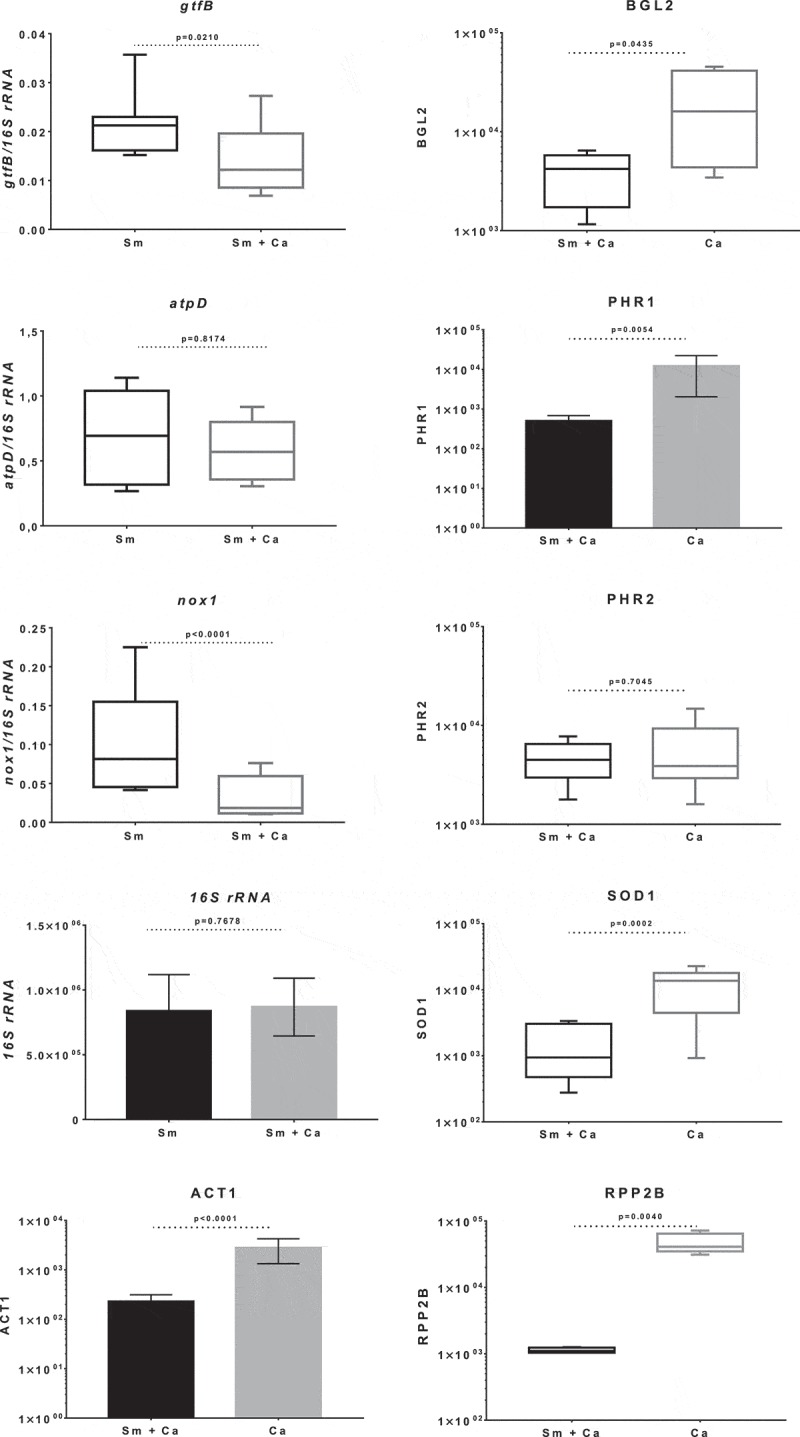
Gene expression of S. mutans and C. albicans in 28 h-old single- and dual-species biofilms. Data presented are mean and standard deviation for genes 16S rRNA, ACT1, PHR1 and RPP2B (bar graphs; unpaired data t-test with Welch correction), while median and interquartile range are shown for the other genes (box plot graphs, Mann Whitney test). The data were obtained from three experiments (with two cDNA per experiment), and the quantification of qPCR expression was performed in duplicate. Sm: S. mutans and Ca: C. albicans.